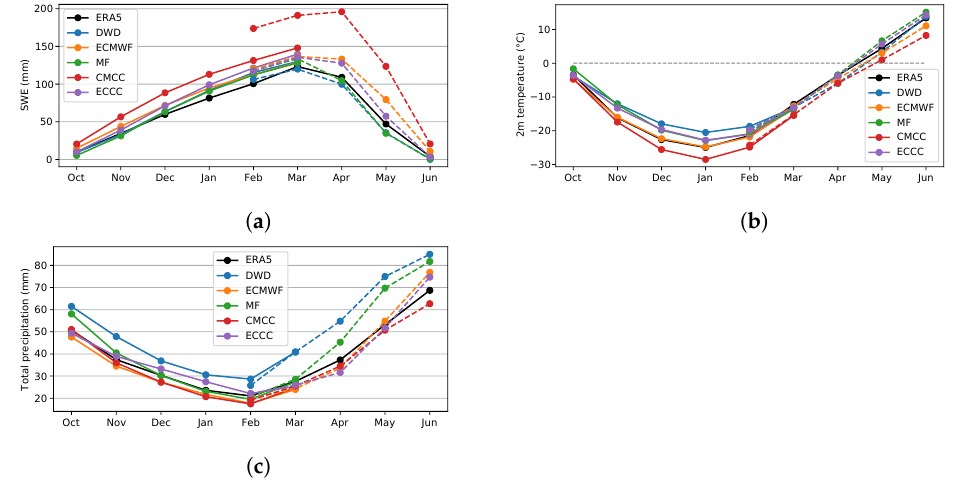
Figure 4. Climatology of SWE ( a ), 2-m temperature ( b ), and total precipitation ( c ) over Siberia with the reference (ERA5) and the seasonal forecasting systems from monthly data (1993–2016). Only starting months from October (solid) and February (dashed) are